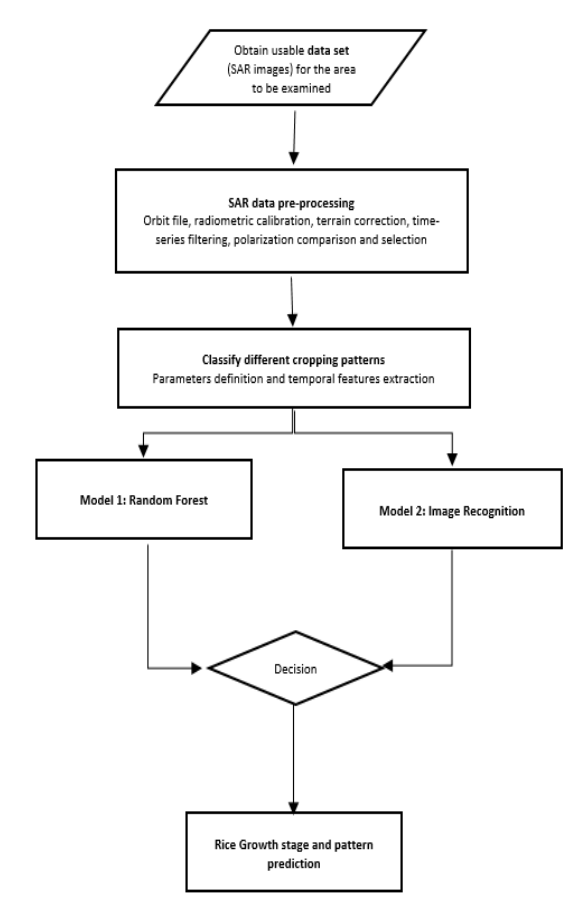
Fig.8: Flow Chart of Knowledge Based